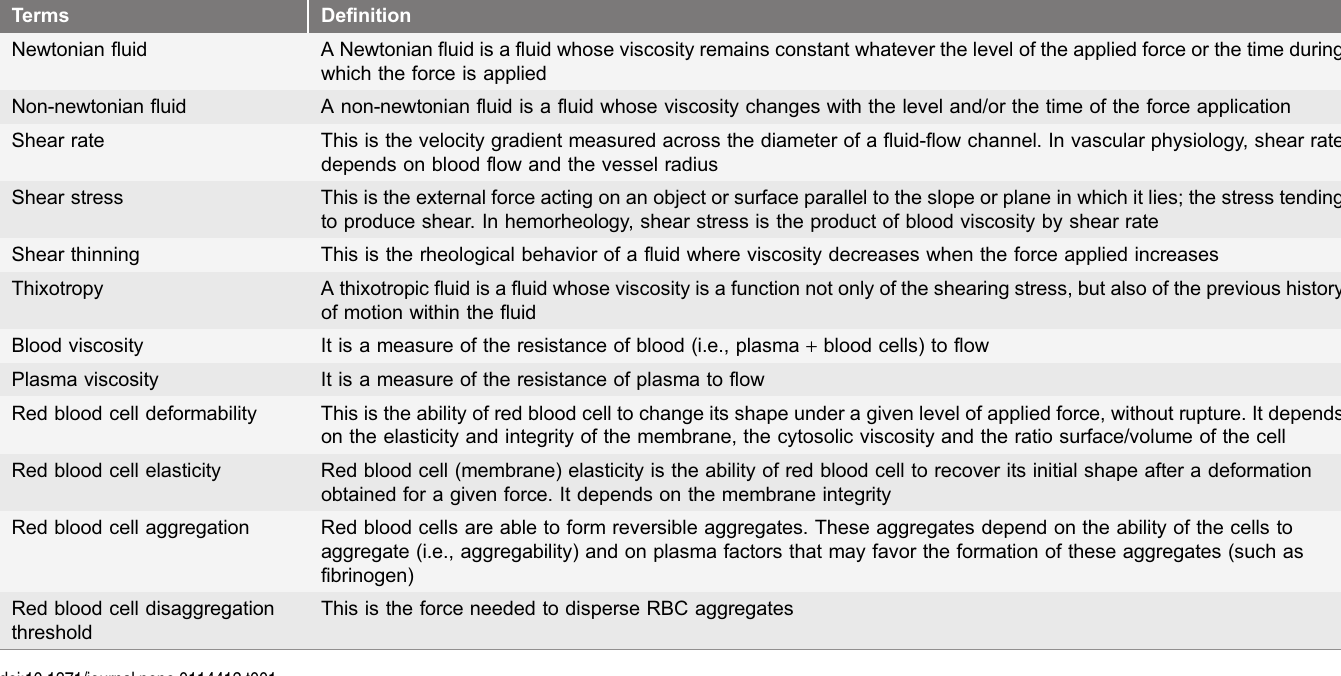
Table 1. Definition of the rheological and hemorheological terms. Terms